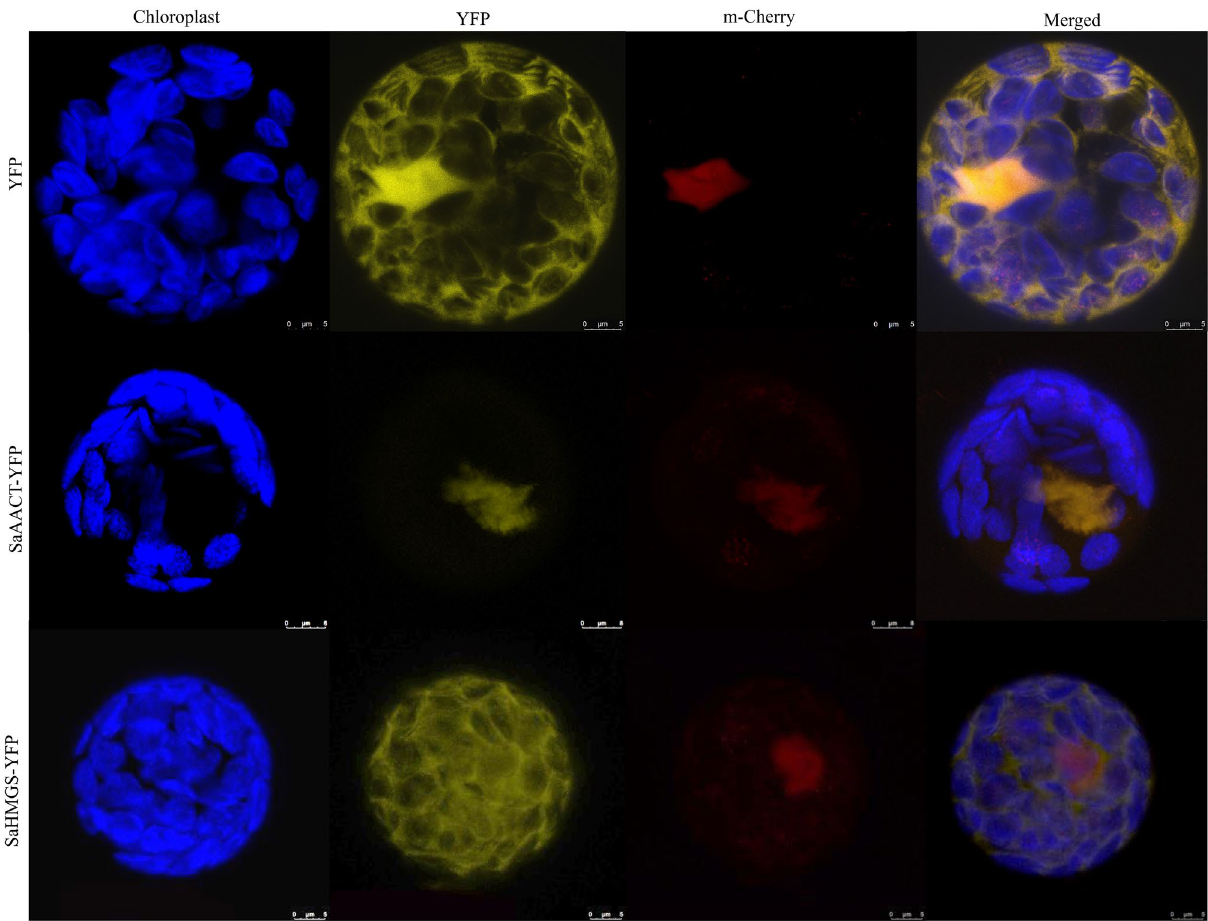
Figure 5. Subcellular localization of SaAACT and SaHMGS proteins in A. thaliana mesophyll protoplasts. Yellow fluorescence indicates SaAACT-YFP and SaHMGS-YFP fusion protein signal. Blue signal indicates chlorophyll (Chl) autofluorescence and red signal indicates m-Cherry fluorescence. The merged images represent a digital combination of Chl autofluorescence, YFP fluorescent and m-Cherry protein fluorescence images. Fluorescence was excited for YFP at 514 nm, for Chl at 543 nm and for m-Cherry at 587 nm. Scale bar of SaHMGS-YFP and YFP = 5 μm and scale bar of SaAACT-YFP = 8 μm.